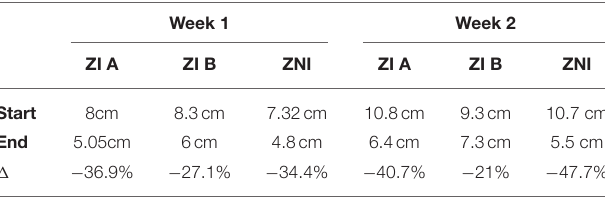
TABLE 1 | Sward height when grazing started and ended, for the first and second experimental week.